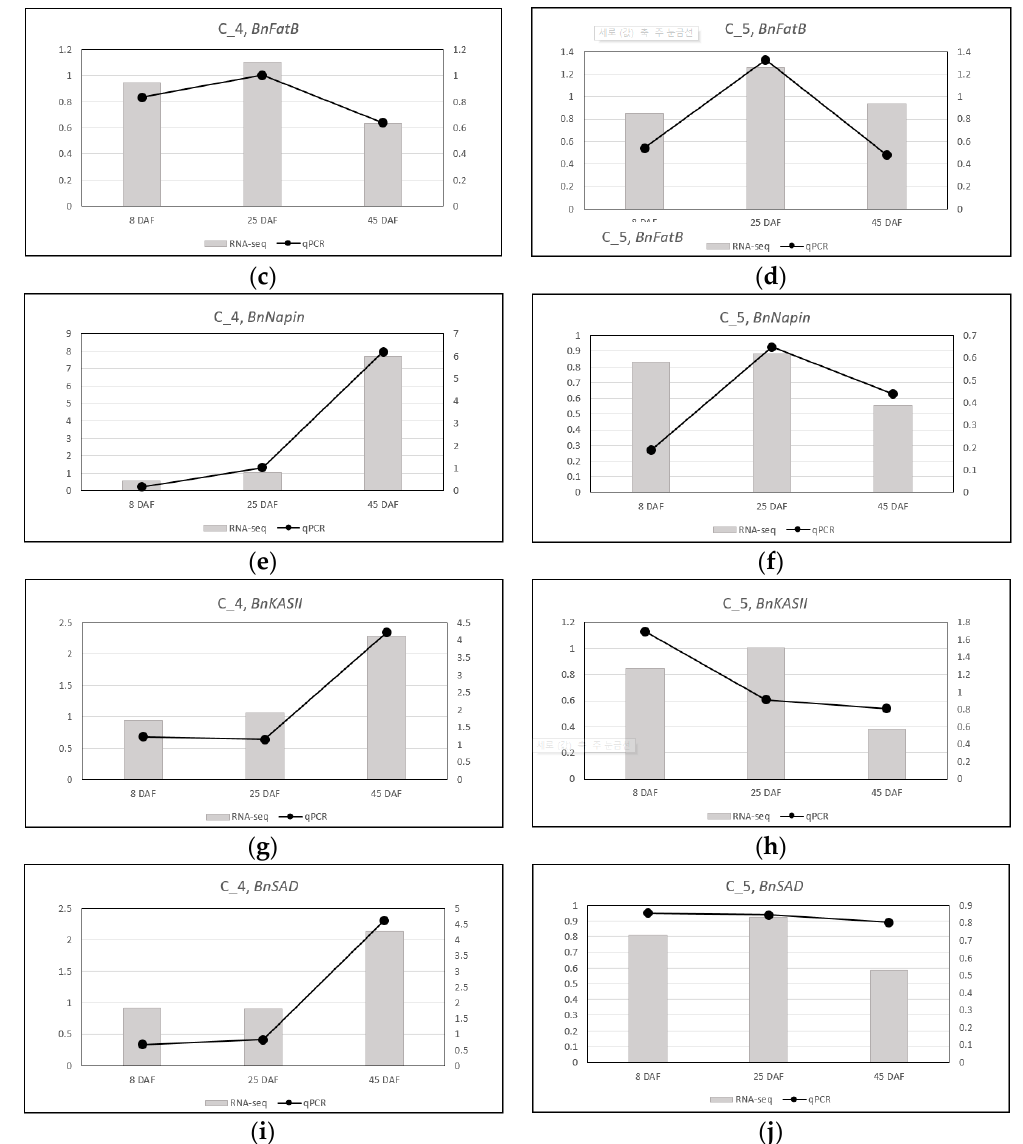
Figure 8. Comparison of RNA-Seq and RT-qPCR expressions of endogenous genes in CpFatB4 and CpFatB5 transgenic plants. ( a , c , e , g , i ) Expression changes of B. napus FatA ( BnFatA ) , FatB ( BnFatB ), Napin ( BnNapin ) , KASII ( BnKASII ), and SAD ( BnSAD ) genes in CpFatB4, compared to control plants (C_4). ( b , d , f , h , j ) Expression changes of B. napus FatA ( BnFatA ) , FatB ( BnFatB ), Napin ( BnNapin ) , KASII ( BnKASII ), and SAD ( BnSAD ) genes in CpFatB5, compared to control plants (C_5). Primary axis (left vertical axis) values are for RNA-Seq and secondary axis (right vertical axis) values are for RT-qPCR.